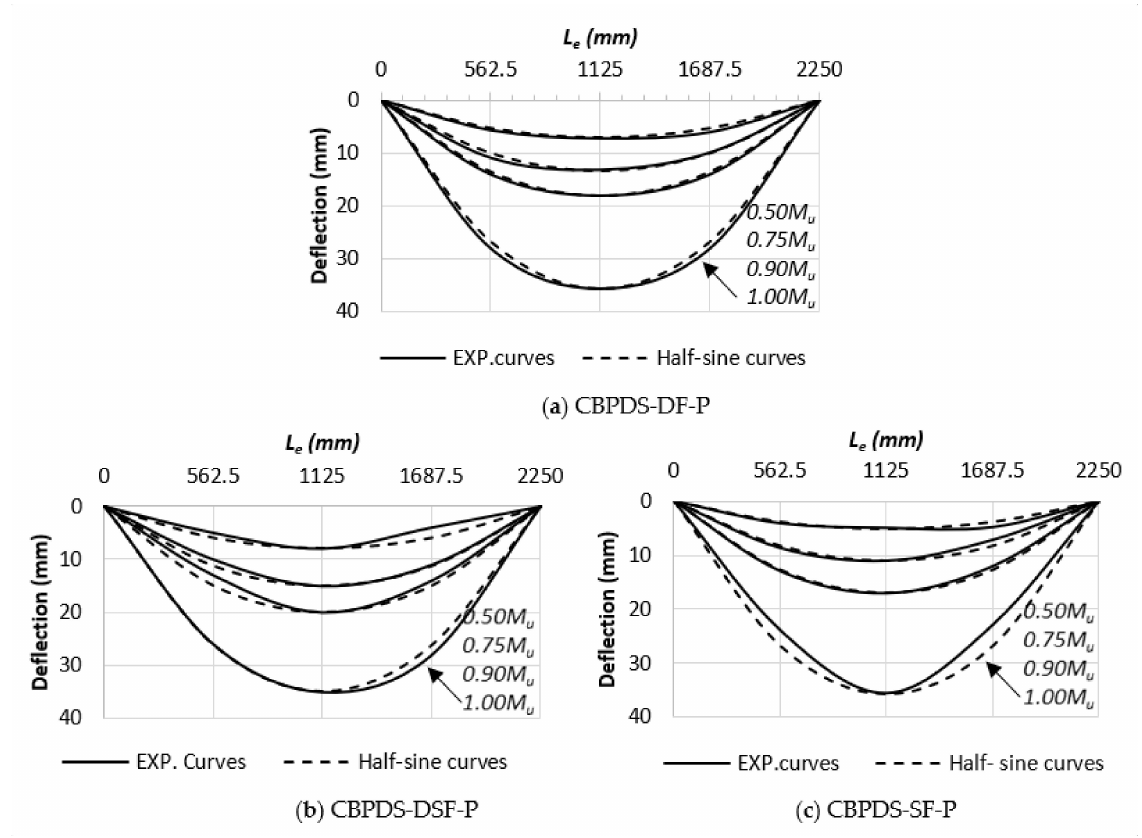
Figure 13. Deflection curves of CBPDS specimens with parallel PSS direction.